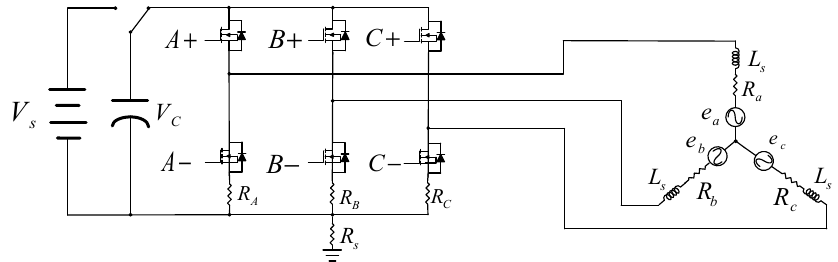
Actuators 2020 , 9 , x FOR PEER REVIEW 7 of 19 Figure 5. Circuit diagram of the system in the braking mode. Figure 5. Circuit diagram of the system in the braking mode.